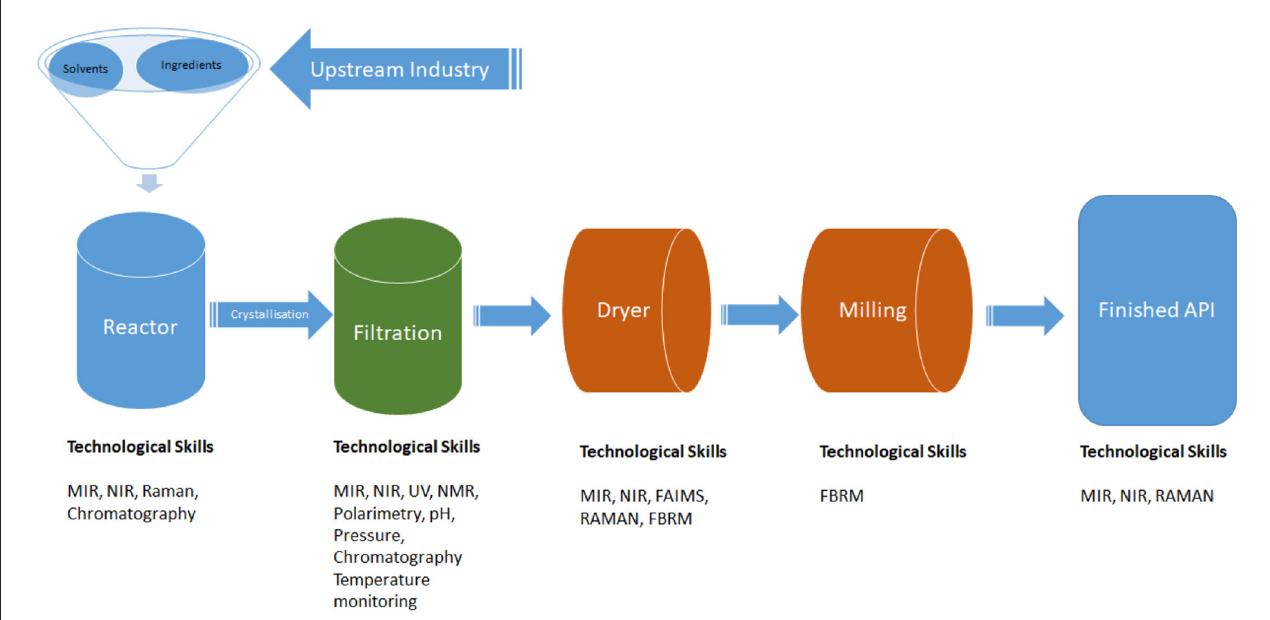
FIGURE2 Schematic representation of the API production process and the technological skills required. Key: MIR, Magnetic Infrared Spectroscopy; NIR, Near Infrared Spectroscopy; Raman, Raman Spectroscopy; UV, Ultraviolet; NMR, Nuclear Magnetic Resonance; FAIMS, Field Asymmetric Ion Mobility Spectrometry; FBRM, Focused beam reflectance measurement. Source: adapted from Yazdanpanah